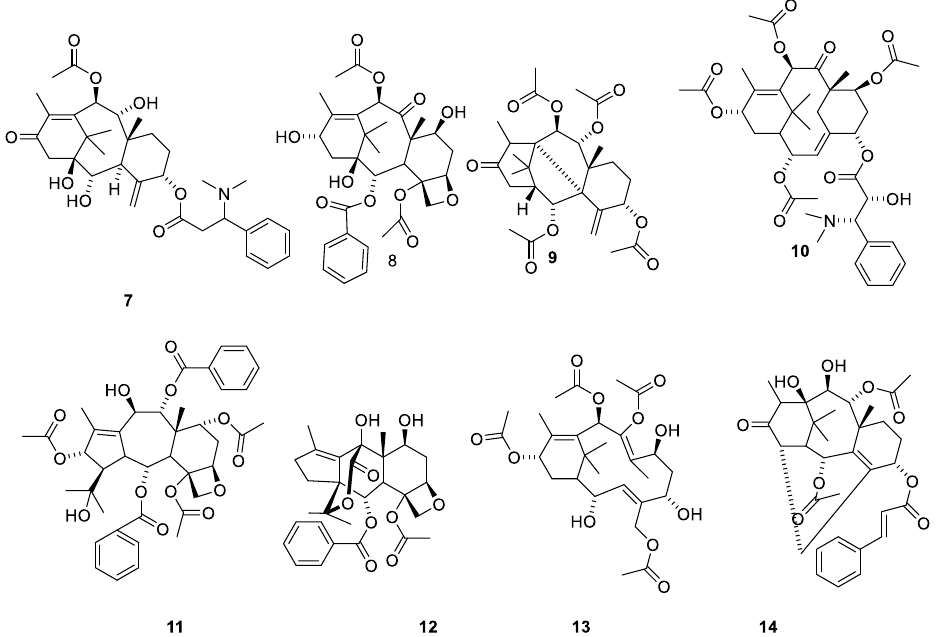
Figure 3. Representative compounds belonging to the 11 groups of diterpenes isolated from Taxus species [14,23]. Taxine B ( 7 ), baccatin III ( 8 ). Taxinine L ( 9 ), α,7β,10β,13α -Tetraacetoxy- 5α - (2′ R,3′ S) – N , N -dimethyl- 3′ -phenylisoseryloxy]-2(3 → 20)abeotaxa-4(20),11-dien-9-one ( 10 ), taxchinine I ( 11 ), tasumatrol j ( 12 ), Tasumatrol M ( 13 ), 2α,9α -Diacetoxy- 5α -cinnamoyloxy- 10β,11β - ihydroxy- 14β,20 -cyclotax-3-en-13-one ( 14 ) [23].